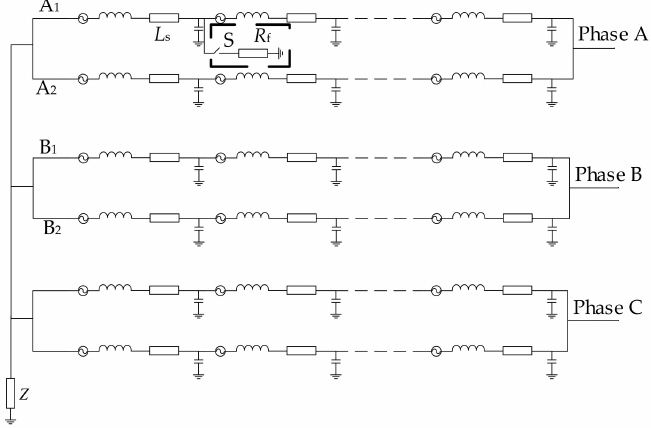
Figure 5. Generator stator winding ground fault simulation model.